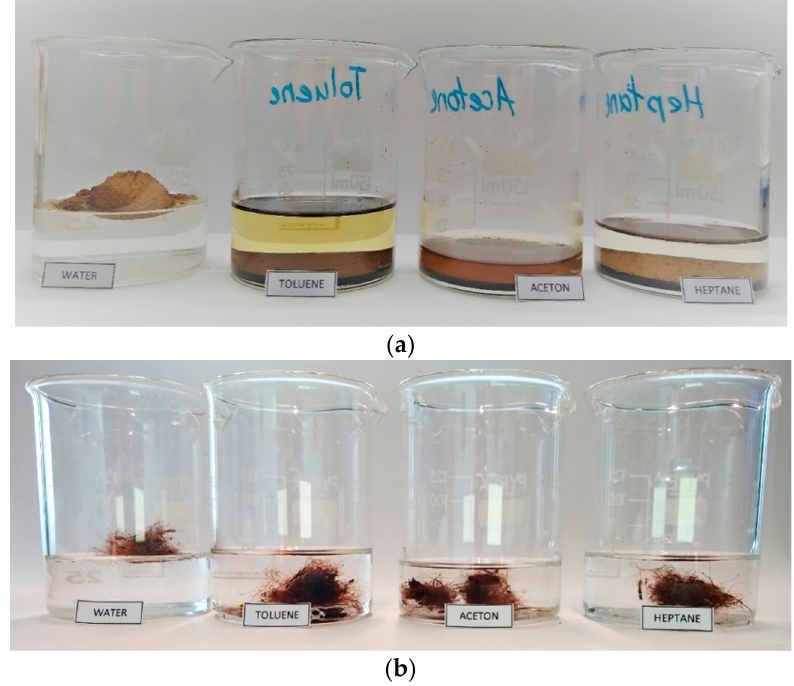
Figure 6. The solubility test of peat ( a ) powder and ( b ) fibers.